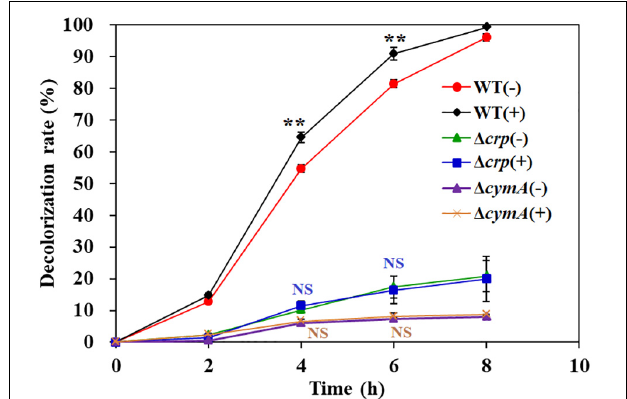
FIGURE 7 | The decolorization of 200 mg/L AY by the WT and Mtr pathway mutants. Values are means ± SD ( n = 3). The decolorization rates of different strains at 4 h were analyzed by ANOVA with the Tukey–Kramer comparison test ( p < 0.05).